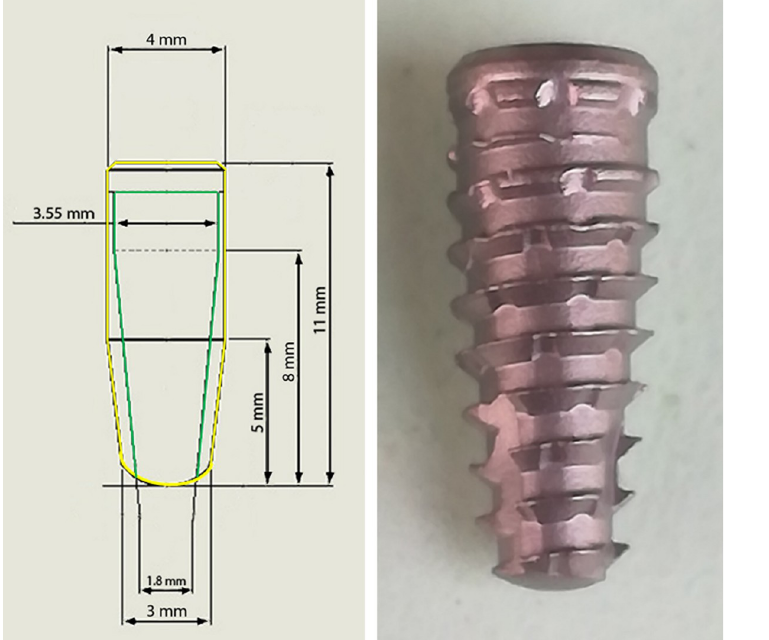
Fig 2. Image of the implant characteristics and design used in the present